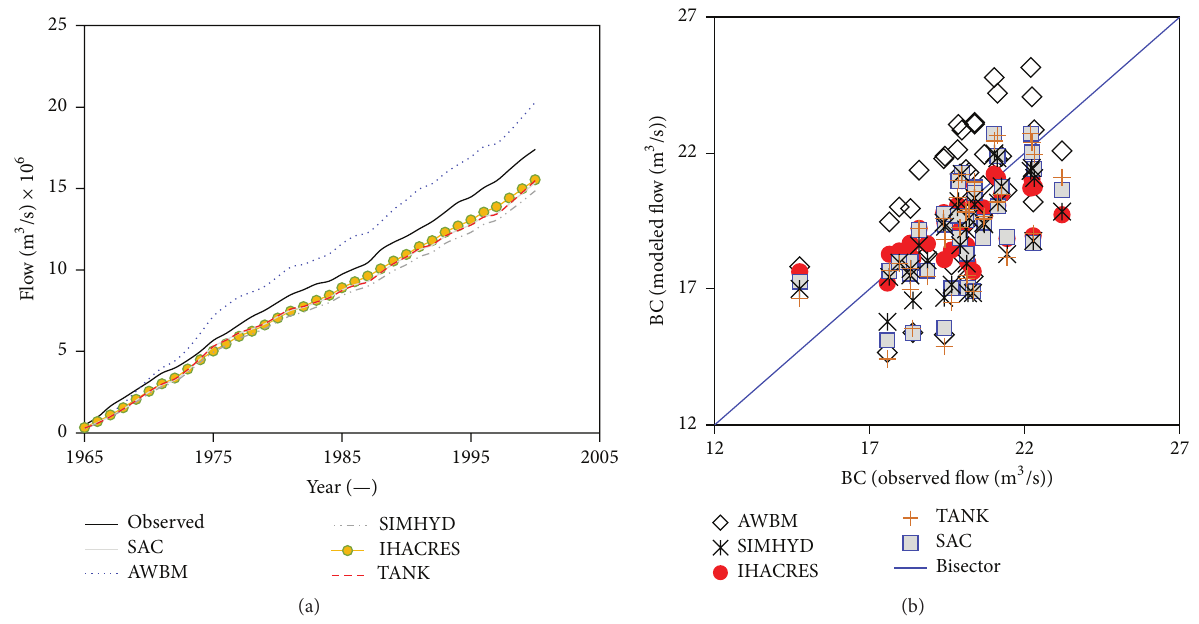
Figure 6: Performance of the models in terms of (a) the cumulative flow and (b) observed versus simulated annual mean flow. For the labels of the axes in chart (b), “BC” appearing before “()” shows that the flow (m 3 /s) values plotted were obtained after applying Box-Cox (BC) transformation using